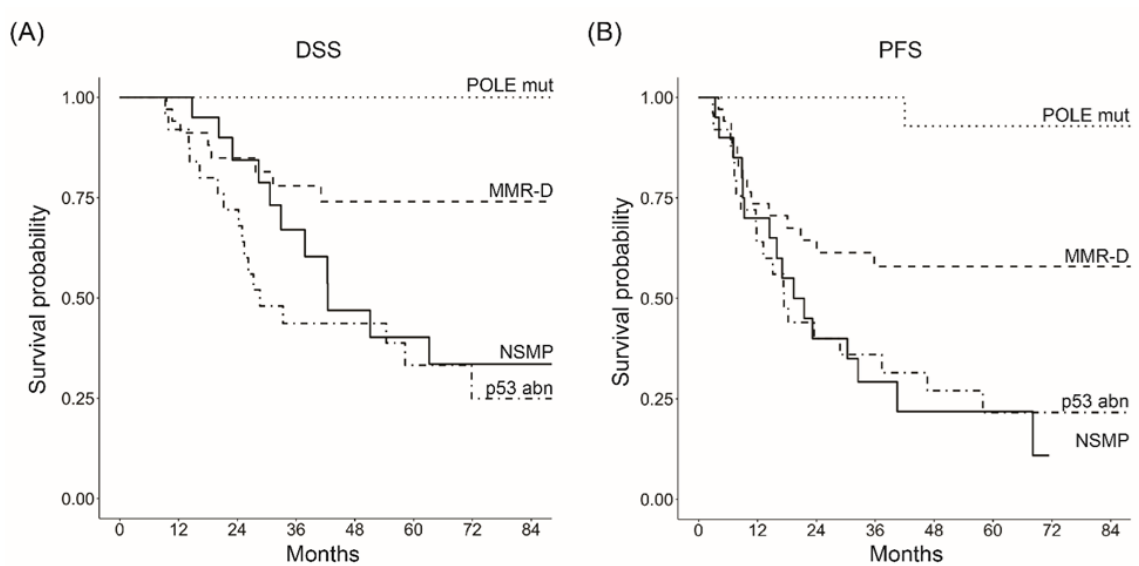
Figure A1. Kaplan–Meier survival curves for disease-specific survival ( A ) and progression-free survival ( B ), according to molecular classification of the Brescia Cohort.